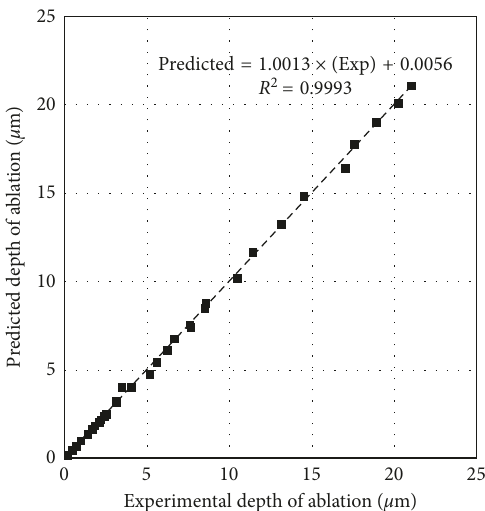
Figure 9: Experimental and ANFIS model-predicted depth of ablation plotted for the best model developed using five input